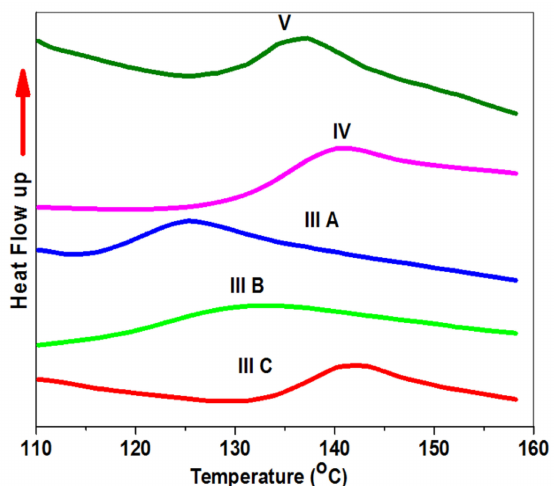
Figure 14. DSC thermogram of copolymers and grafted copolymers for determination of glass transition temperature ( T g ).